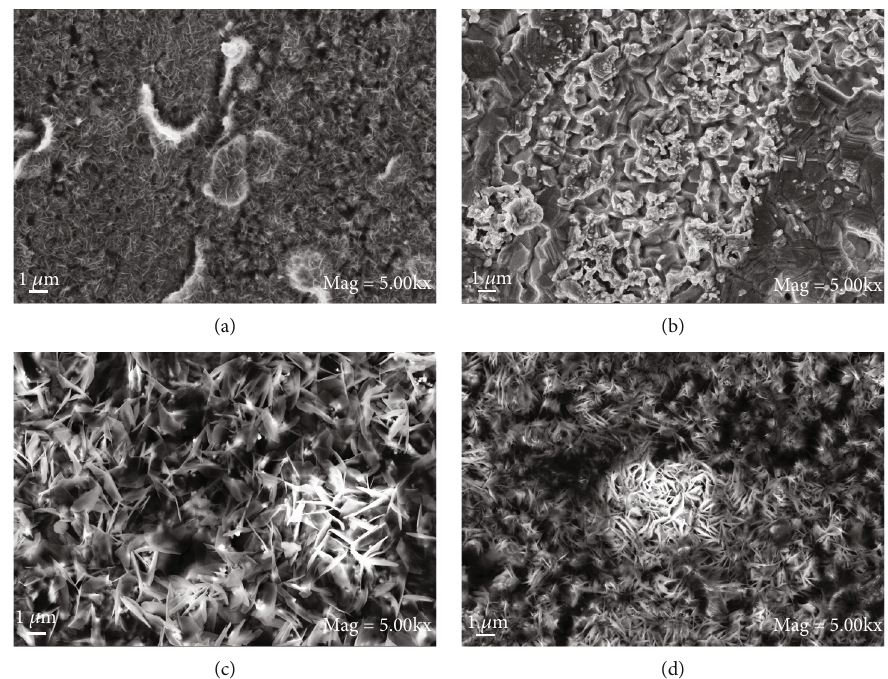
Figure 4: SEM images of zinc foils by electrowinning (a) without additives; (b) gelatin; (c) thiourea; (d) gelatin+thiourea.